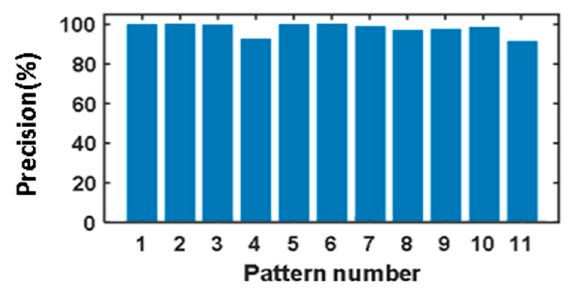
Figure 9. The precision for the 11 fault patterns.